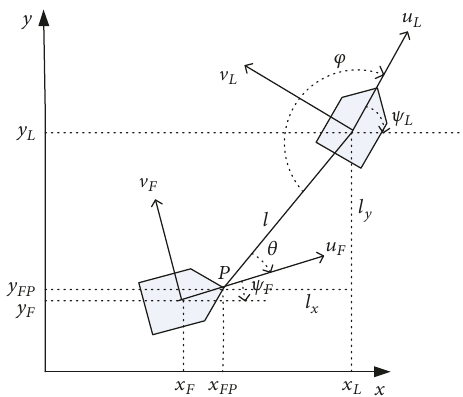
Figure 1: Leader-follower formation configuration with the control point